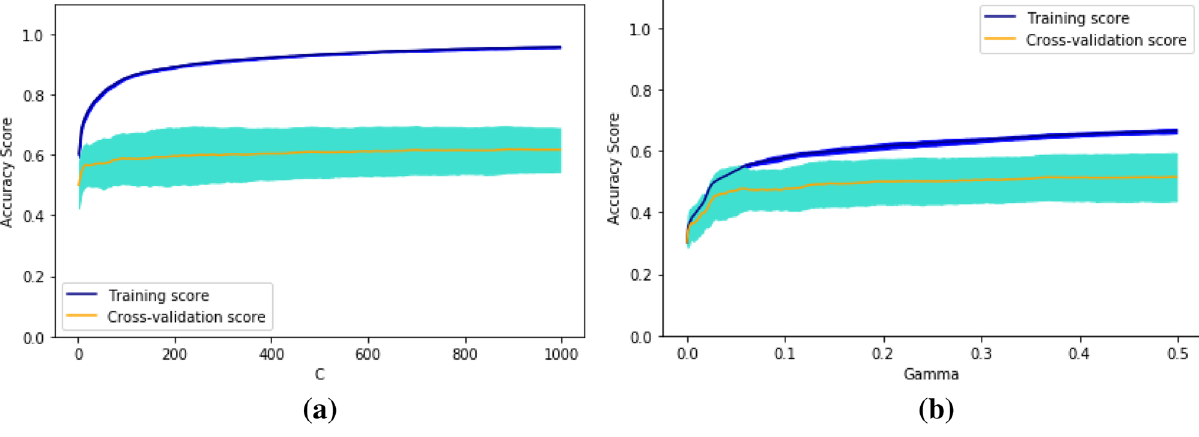
Fig. 9 Validation curves for SVM classifier to identify stable search range for two primary model parameters. a Penalty cost parameters for mis- classified error samples and b kernel coefficient of